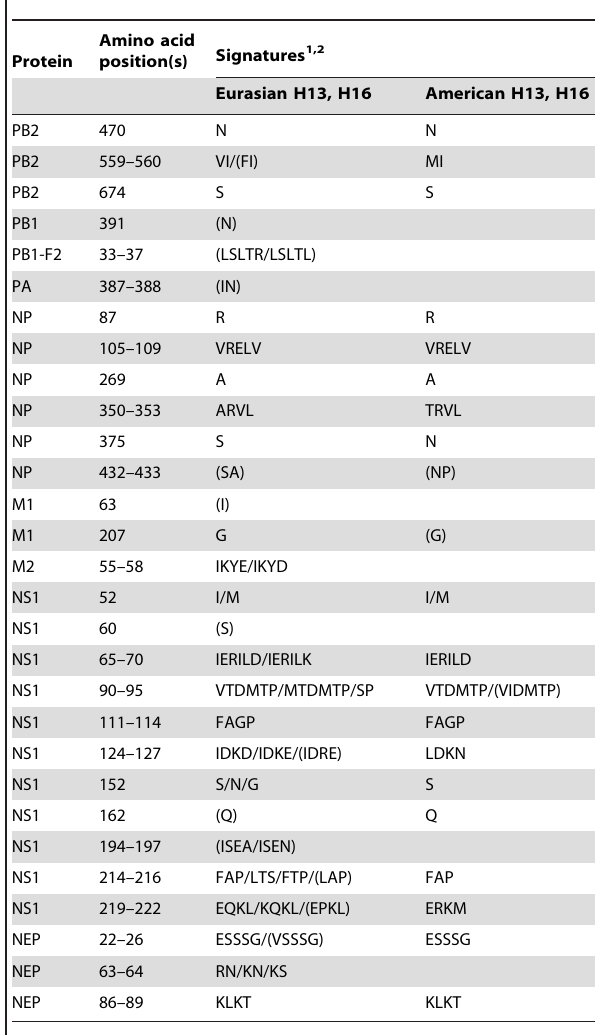
Table 1. Amino acid signatures found mostly or entirely in the internal proteins of Eurasian and American H13 and H16 AIVs from gulls and shorebirds, validated against a comprehensive set of AIV sequences in